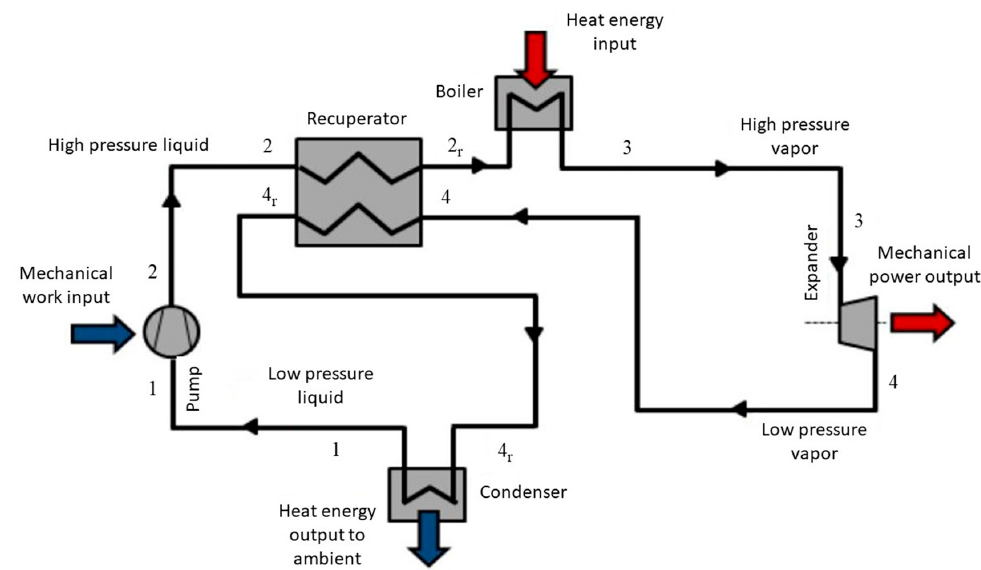
Figure 9. Recuperative ORC System Layout.